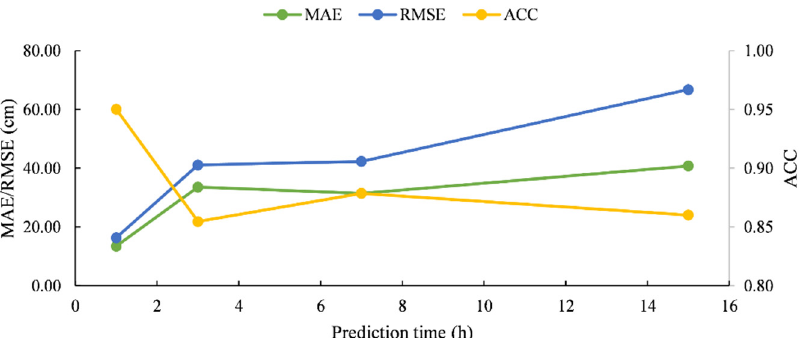
Figure 5. Model results of testing set for the LSTM model with ( a ) 1 h, ( b ) 3 h, ( c ) 7 h, and ( d ) 15 h prediction times. Red dash line circle represents the maximum difference between the modelled and observed values at the water level peak. Light blue areas are the cold start subsets for all prediction times.